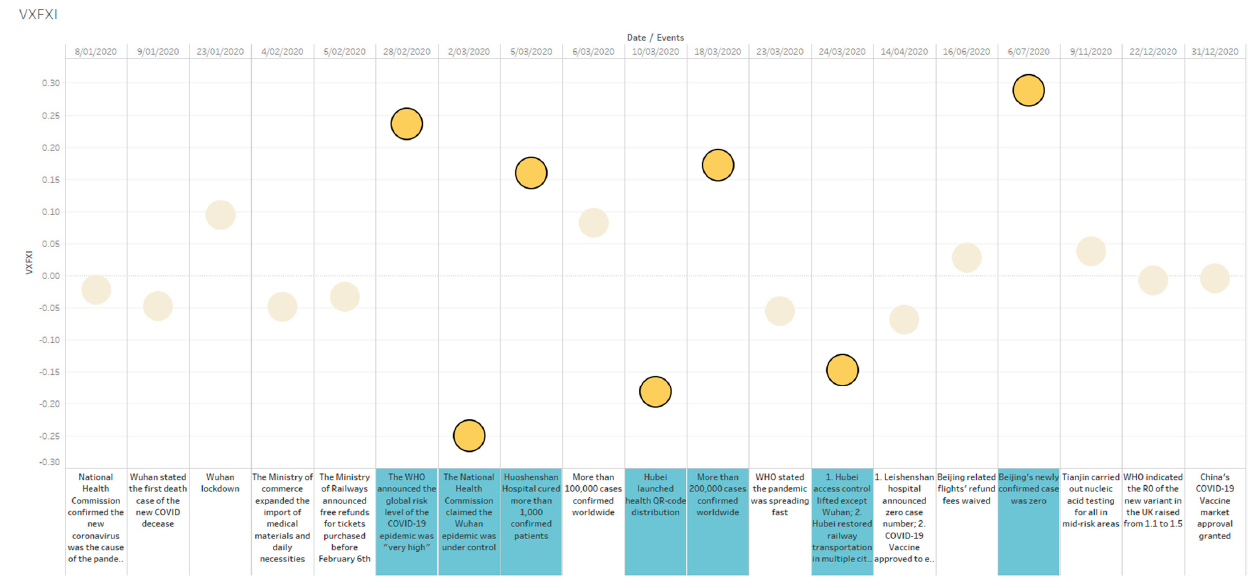
Figure 7. VXFXI’s trends on relevant social events.